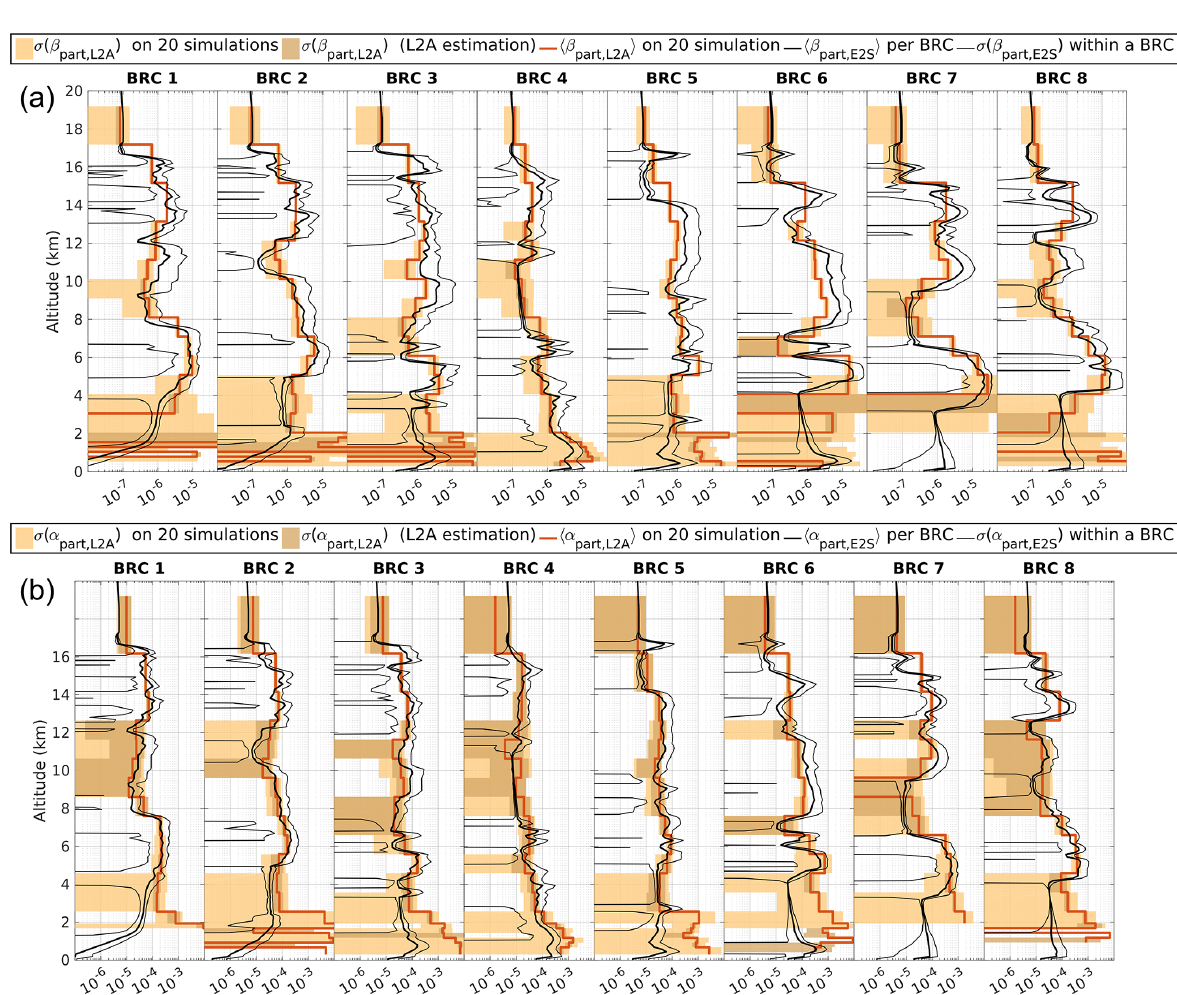
Figure 13. Backscatter (a) and extinction profiles (b) comparison between E2S simulations processed up to the SCA mid-bin product and the E2S inputs. The black line is the simulation input parameters averaged within each BRC. The thin black line represents the associated standard deviation. Red profiles are the mean coefficients retrieved by the SCA from 20 realizations. Lighter shading is the associated standard deviation, i.e. the true variability. Darker shading delimits the mean error estimated by the SCA error propagation